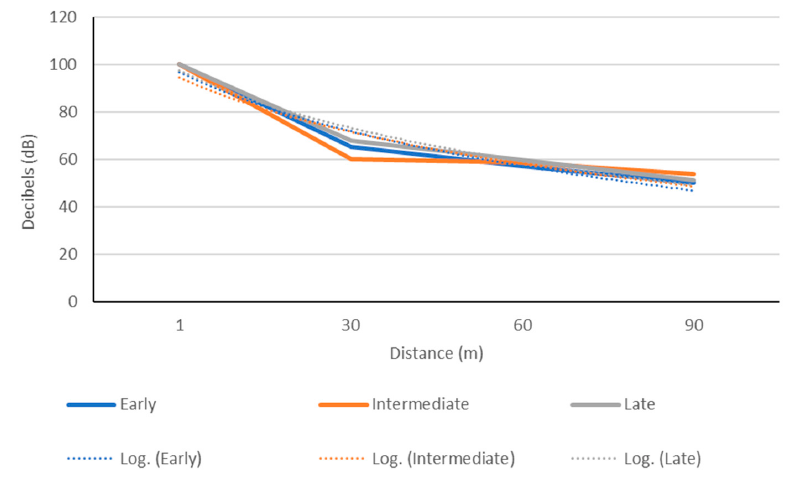
Figure 2. Low-frequency bird call playback attenuation in decibels related to distance from the sound source at three different forest age classes. The logarithmic curves generated from the inverse distance law equation are shown for each age class (dotted lines).